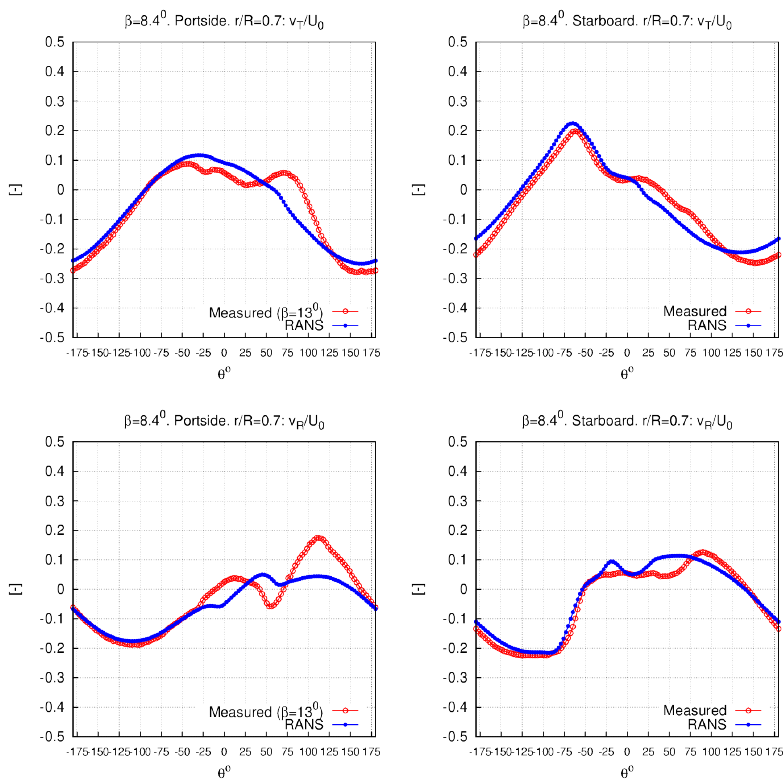
Figure 11. Nominal wake of the model hull in steady drift motion. Tangential ( top ) and radial ( bottom ) velocity component at r / R = 0.70 radial section. ( Left ) portside propeller. ( Right ) star- board propeller.